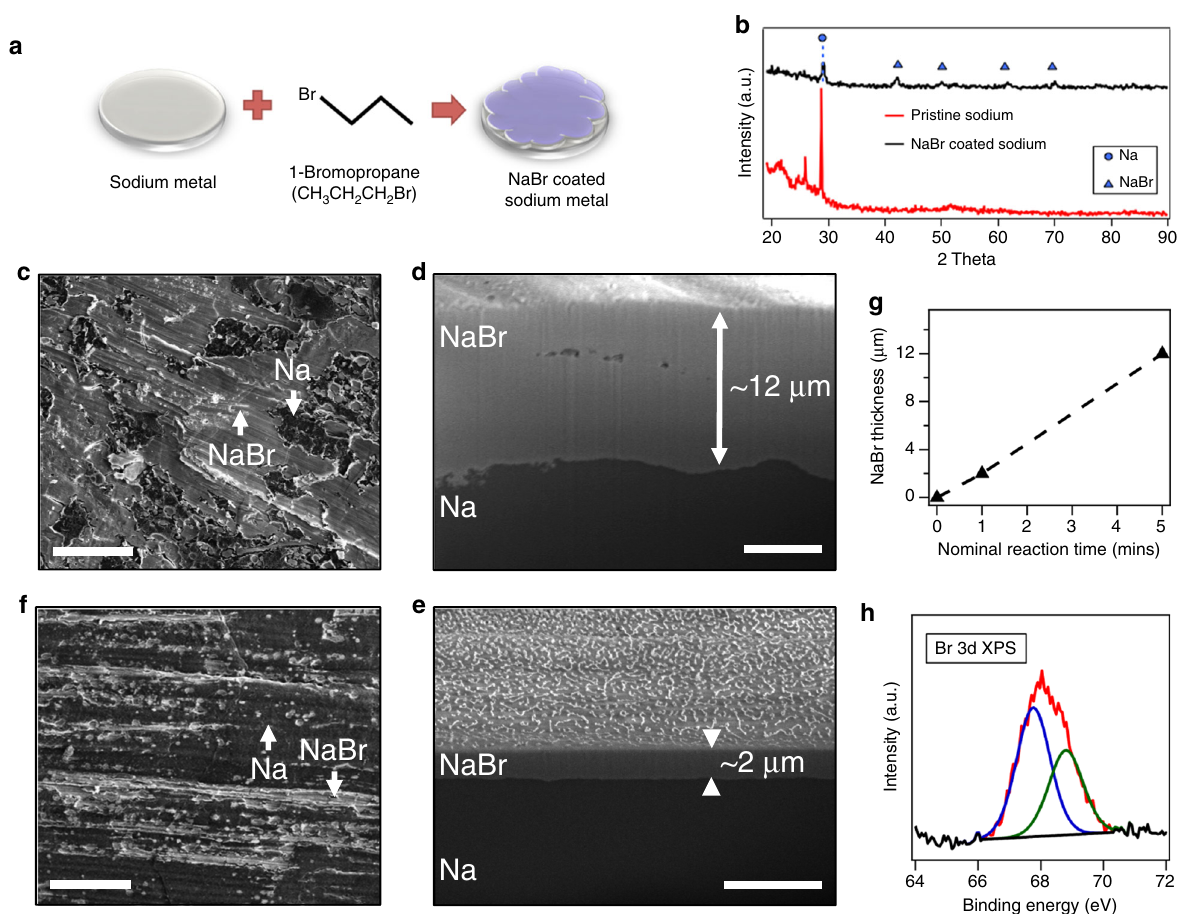
Fig. 2 Formulation and characterization of sodium bromide layer. a Schematic showing the procedure used to coat Na with NaBr. b XRD analysis of pristine and NaBr-coated sodium showing that NaBr exists in crystalline form in the coatings on Na. c Cryo-SEM image of ~ 12 µ m thick NaBr coating on sodium metal surface. Light regions are NaBr coating and dark regions are sodium metal, as con fi rmed by EDX; scale bar , 200 µ m. d Cryo-SEM image of a cross section through the NaBr coating obtained by focused ion beam milling under cryogenic conditions. Cross-sectional SEM imaging was used for layer thickness analysis, and the layer composition was con fi rmed by EDX mapping; scale bar , 5 µ m. e , f Complementary images and scale bars as ( d , c ), respectively, but for a Na substrate exposed to 1-bromopropane for 1 min. A thinner (2 µ m) NaBr coating is formed in this case. g Thickness of